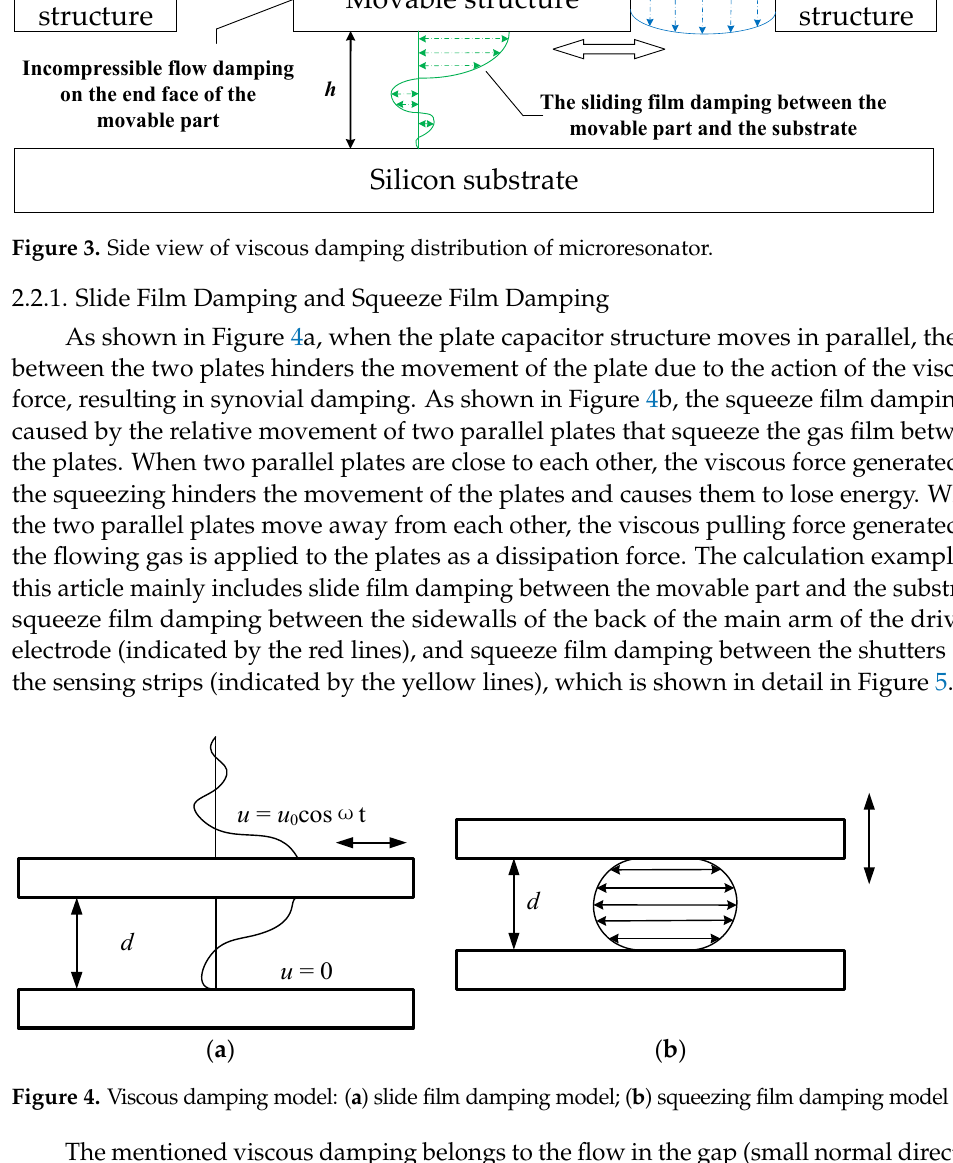
Figure 5. Schematic diagram of the squeeze film damping distribution in the 1/4 solution domain: red and yellow lines indicate squeeze film damping between the sidewalls of the back of the main arm of the driving electrode and between the shutters and the sensing strips, respectively. The mentioned viscous damping belongs to the flow in the gap (small normal direc- tion and large tangential direction), whose viscous force is dominant, ignoring the inertial force. Therefore, the flow equation is established in the tangential direction, regardless of the normal pressure difference. Based on the above simplification, a simulation model is established. A schematic diagram of the model is shown in Figure 6. wall Reference surface base hh w h b v wall v base Figure 6. Schematic diagram of the thin film flow interface [29]. The thin film fluid in the gap has two surfaces: the wall and the base, which corre- spond to the lower surface of the movable structure and the upper surface of the substrate, the sidewalls of shutters and the adjacent sidewall of the sensing electrodes, and the side- walls of the main arm of the movable driving electrode and the sidewalls of the adjacent